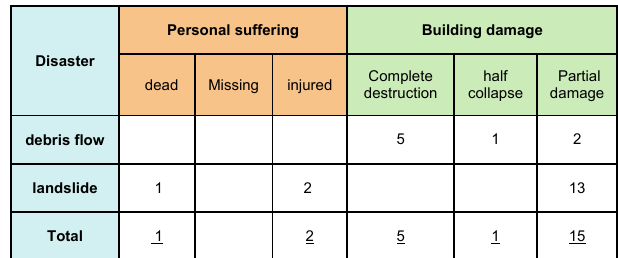
Table 3. Damage situation of the sediment disasters in Oita